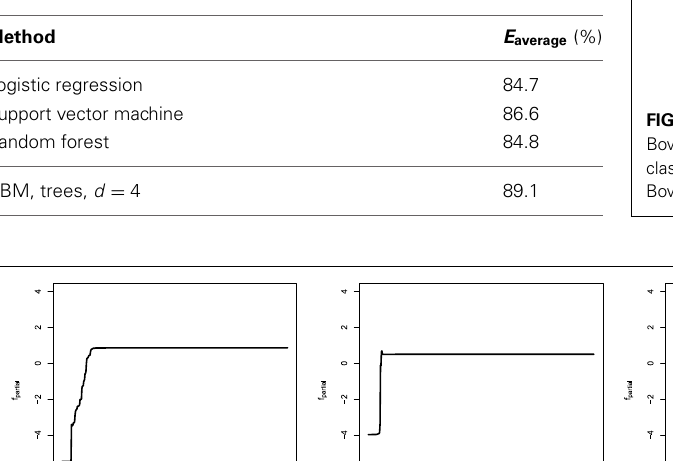
Table 3 | Machine learning algorithm accuracy.